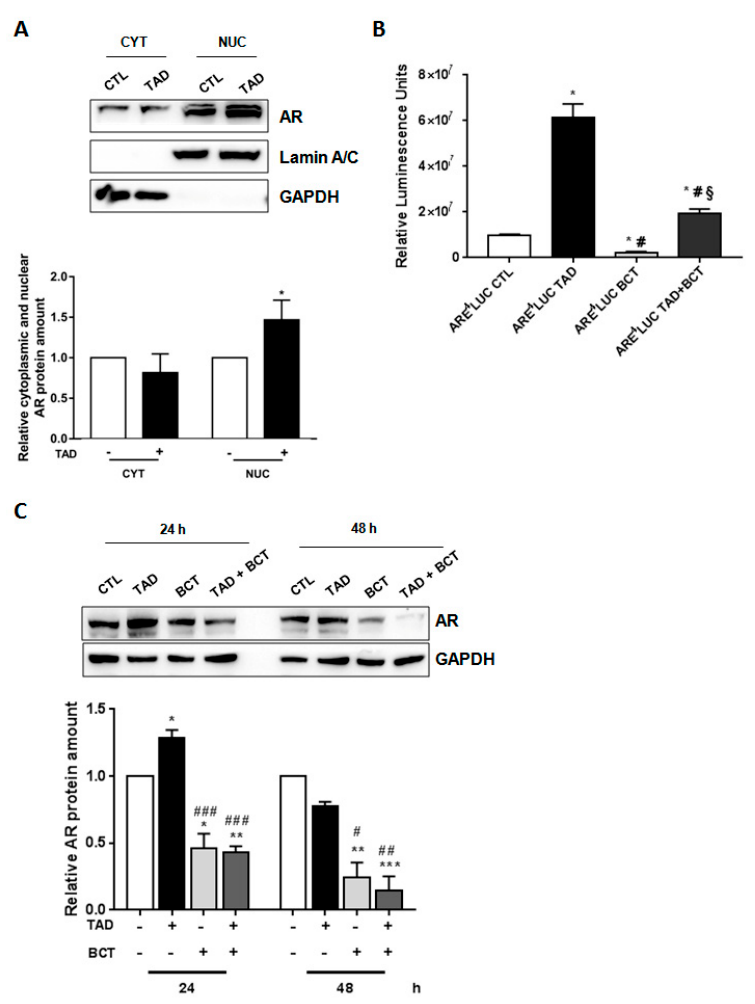
Figure 2. TAD boosts AR function and increases BCT-mediated AR downregulation. ( A ) Analysis of cytoplasmic (CYT) and nuclear (NUC) fractions of AR in LNCaP cells cultured in the presence (+) or in the absence ( − ) of TAD (10 − 6 M) for 15 min. GAPDH and Lamin A/C were used as loading and purity controls of each cellular fraction. ( B ) Effects of TAD on AR transcriptional activity. LNCaP were transfected with ARE 4 LUC and treated in the presence (+) or in the absence ( − ) of TAD (10 − 6 M) and BCT (10 − 4 M). Luciferase activity was measured after 24 h. ( C ) Representative Western blot analysis of AR protein expression in cultured cells either in the presence (+) or in the absence ( − ) of TAD (10 − 6 M) and/or BCT (10 − 4 M) for 24–48 h. In Western blot, GAPDH was used as a control of protein loading. Results are represented as mean ± SE ( n = 3) of three separate experiments. * p < 0.05, ** p < 0.005, *** p < 0.001 vs. CTL cells, # p < 0.05, ## p < 0.005, ### p < 0.001 vs. TAD treated cells, § p < 0.05 vs. BCT treated cells.